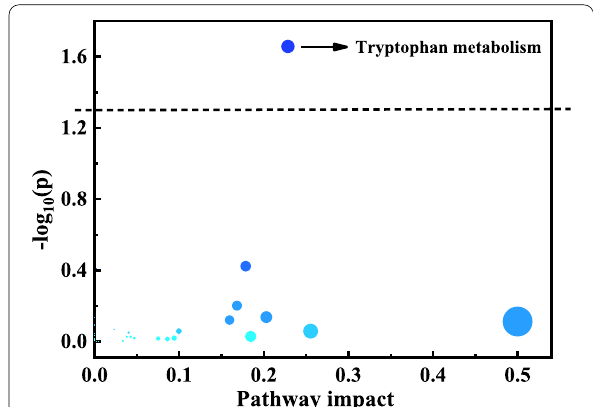
Fig. 7 Significance analysis of factors impacting metabolic pathways for all cultures. The horizontal dotted line indicate the cutoffs for obvious statistical significance ( P < 0.05). Significance ranges from moderately (shallow blue) to highly significant (blue). The size of circles correlates with the number of metabolites identified in